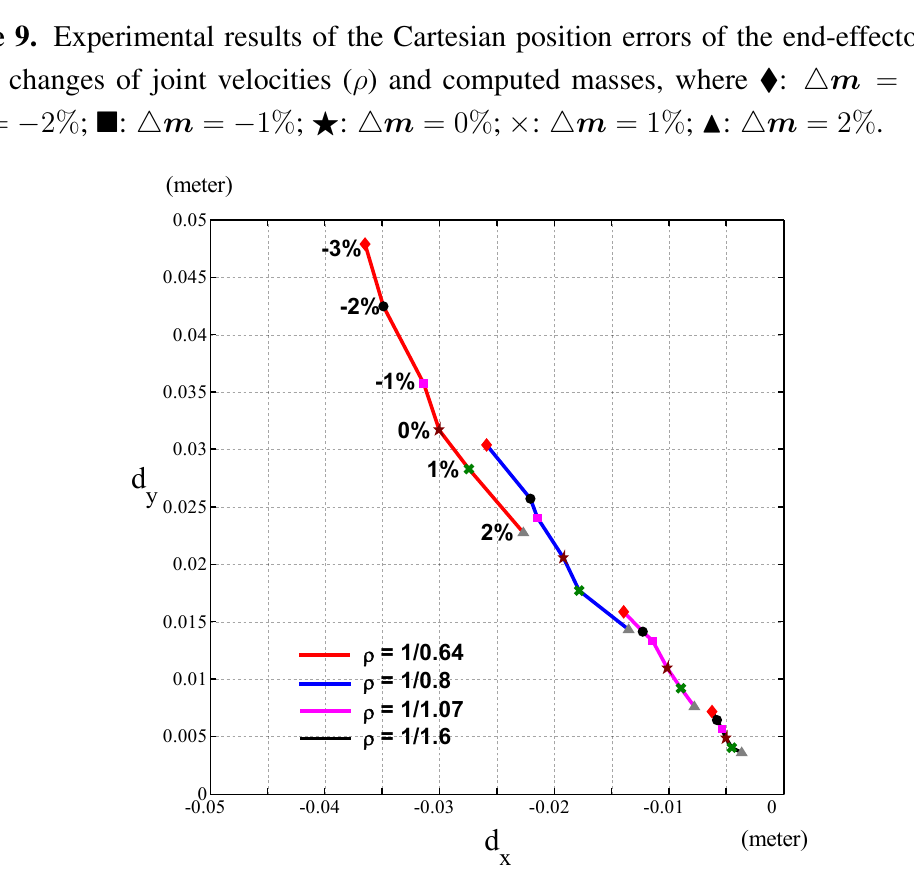
Figure 9. Experimental results of the Cartesian position errors of the end-effector